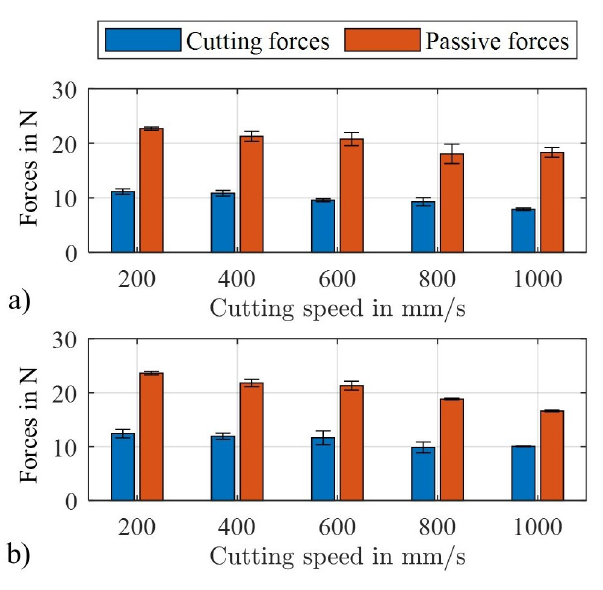
Figure 5. Measured process forces during single grit scratching with cutting speeds 200 mm/s < v v < 1000 mm/s and depth of cut a p = 50 µm with a conical indenter of cone angle 105 ◦ ( γ = − 52.5 ◦ ) ( a ) and cone angle 120 ◦ ( γ = − 60 ◦ ) ( b